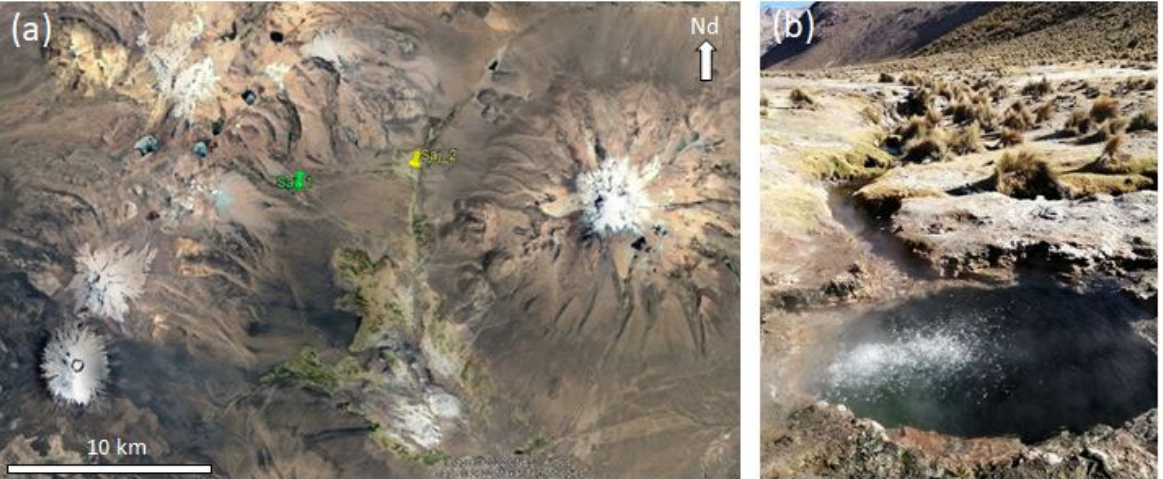
content was null.